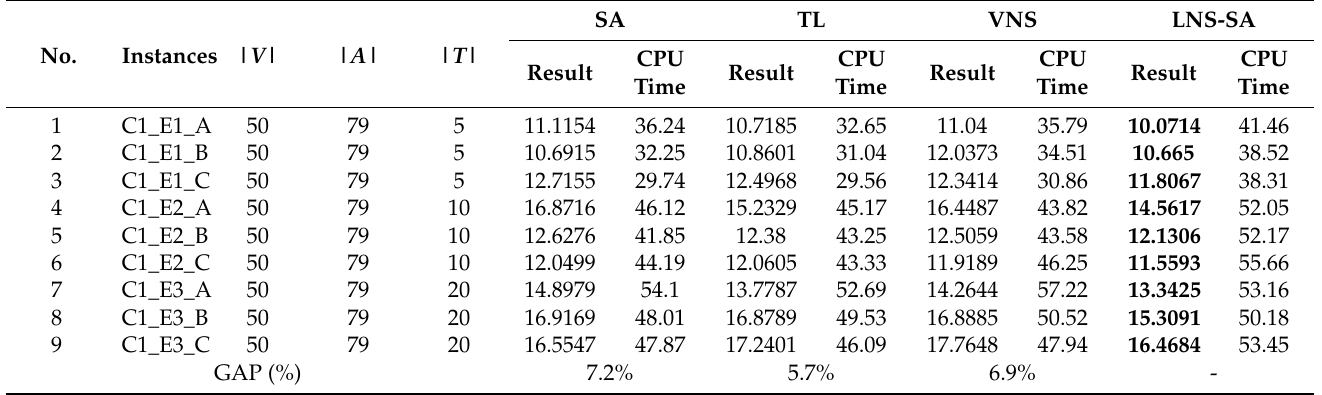
Table 4. Algorithm Performance on C1 Instances.